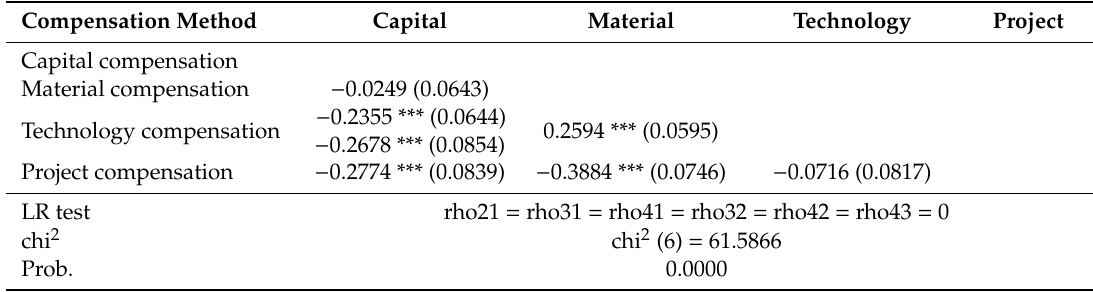
Table 3. Covariance variance of multivariate probit